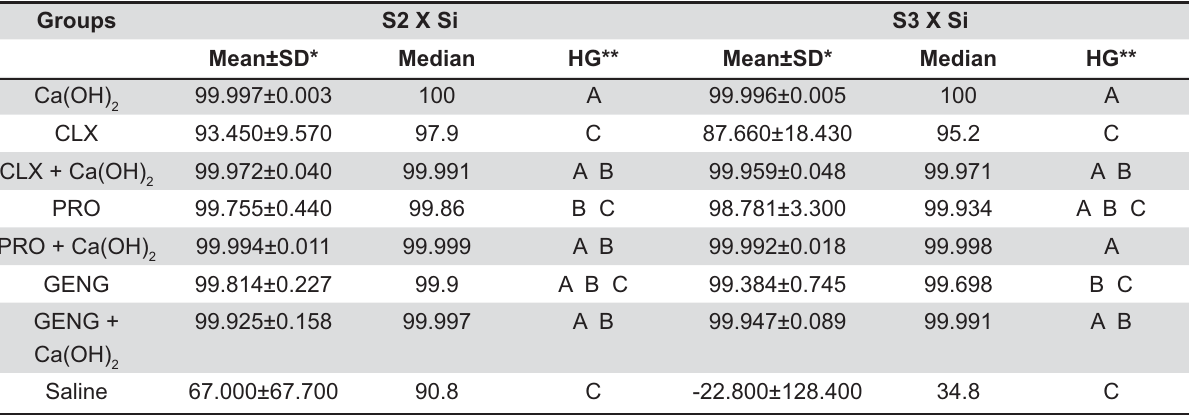
Table 2- Percent change obtained in S2 and S3 in relation to Si: mean, standard deviation, median and homogeneous groups regarding the decrease or increase in the amount of endotoxins